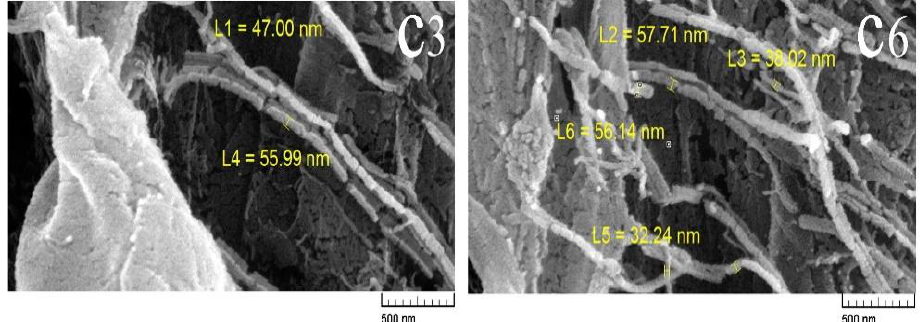
Figure 4. FE-SEM images of C3 and C6 hydrogels.